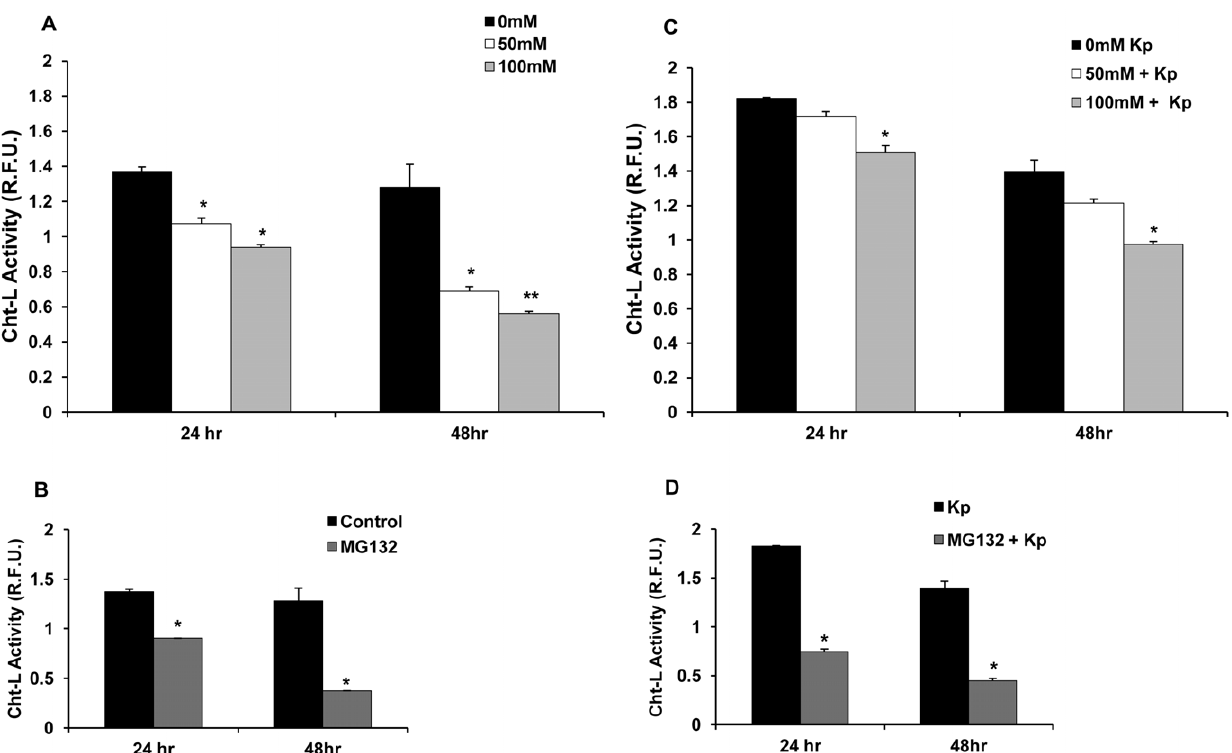
Figure 3. Ethanol suppresses 20S Cht-L proteasome activity in murine primary peritoneal macrophages. A. Murine peritoneal macrophages (2.5 6 10 5 cells/ml) were treated with 50 mM or 100 mM EtOH for 24 h or 48 h. 0 mM (control) cells received no treatment. Cell lysates obtained at the indicated time points were analyzed for 20S Cht-L proteasome activity by fluorigenic assay as described in Methods. B. Peritoneal macrophages were treated with MG132 (5 uM), as a positive control of proteasome suppression. Cell lysates were obtained at the indicated time points and analyzed as described in Panel A. C. Ethanol-treated peritoneal macrophages were stimulated with heat-killed Kp , 6 hours after initial EtOH exposure. Cell lysates obtained at indicated time points were analyzed for proteasome activity as described in panel A. D. MG132-treated peritoneal macrophages were stimulated with Kp as described in Panel C. Cell lysates were obtained at the indicated time points and analyzed for proteasome activity as in Panel A. Proteasome activity data plotted as mean relative fluorescence units (R.F.U.) 6 SEM (three replicates per experiment) and is representative of three independent experiments. Higher R.F.U. values indicate higher proteasome activity. *p , 0.05 vs. control at the respective time point. **p , 0.05 vs. control and 50 mM EtOH at the respective time